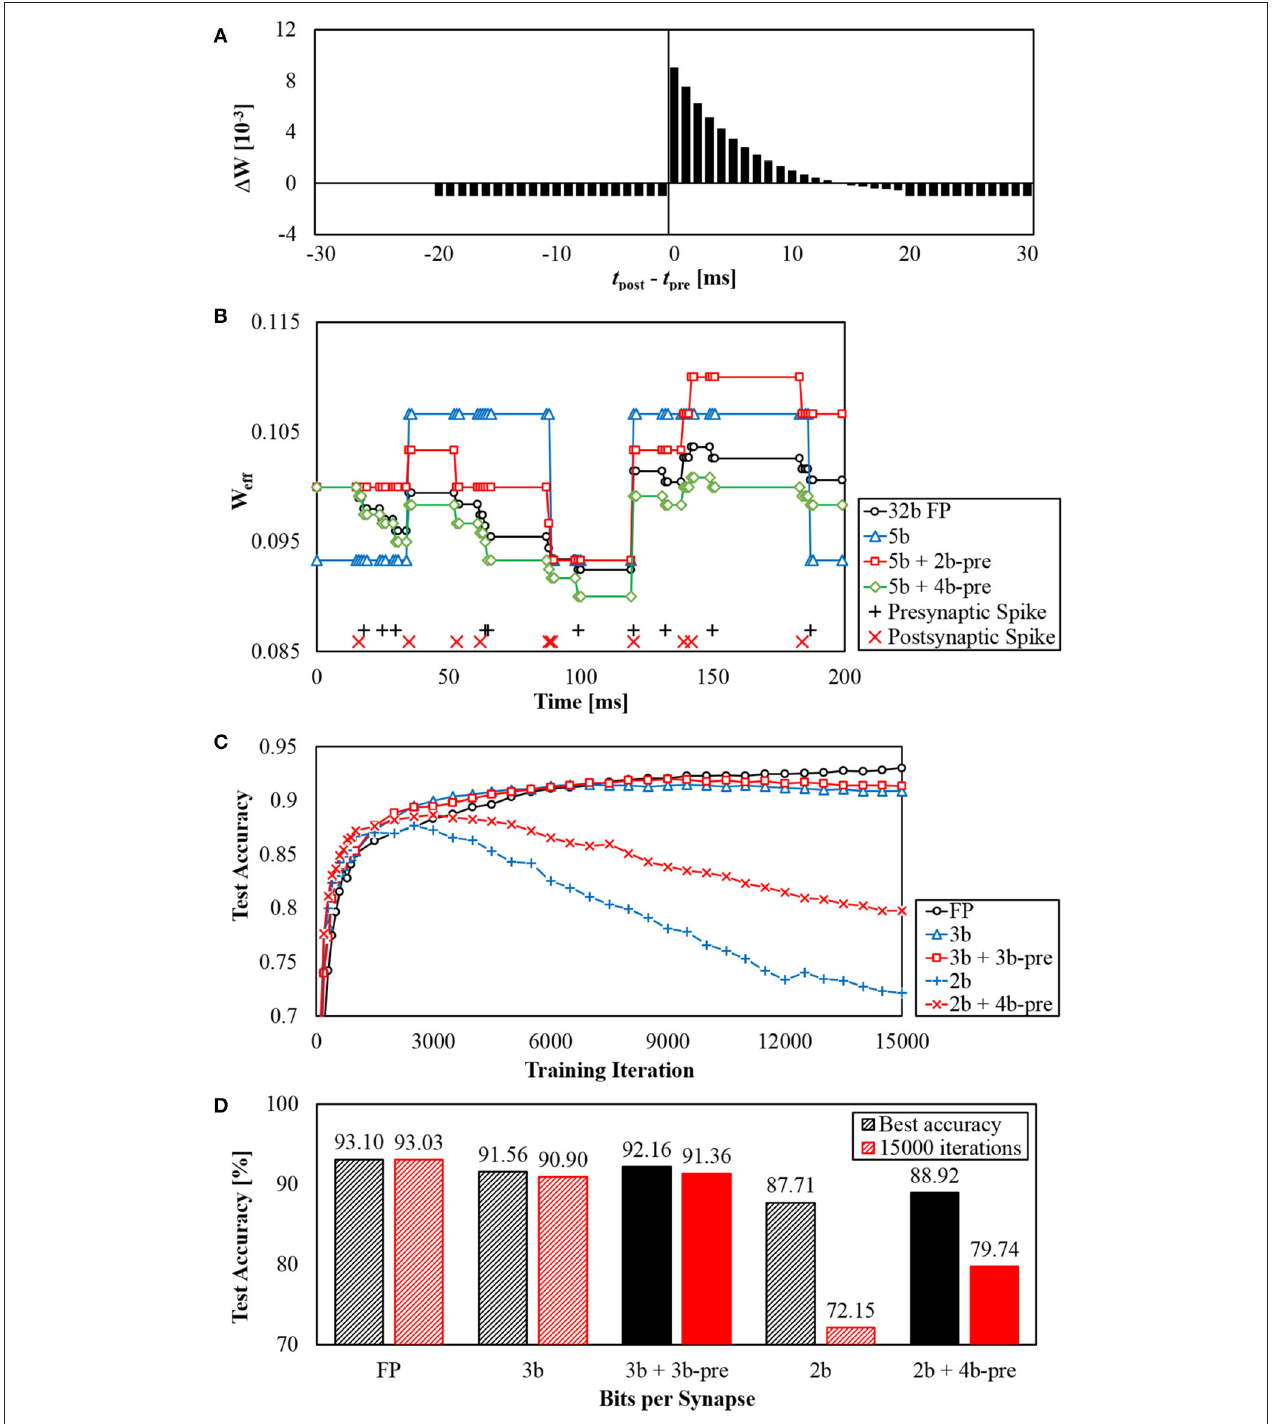
FIGURE 9 | (A) STDP kernel function used, (B) Example of effective weights changed through STDP learning with different synaptic weight precision, and (C,D) MNIST accuracy results from using STDP + SVM classifier. as in Kheradpisheh et al. (2018). At each training iteration, one To see its influence on accuracy as we used STDP as an unsupervised learning method, we added and trained a linear training image was shown to the network. At every 100 iterations, Support Vector Machine (SVM) classifier after the STDP layer we trained a new SVM classifier using only images that we